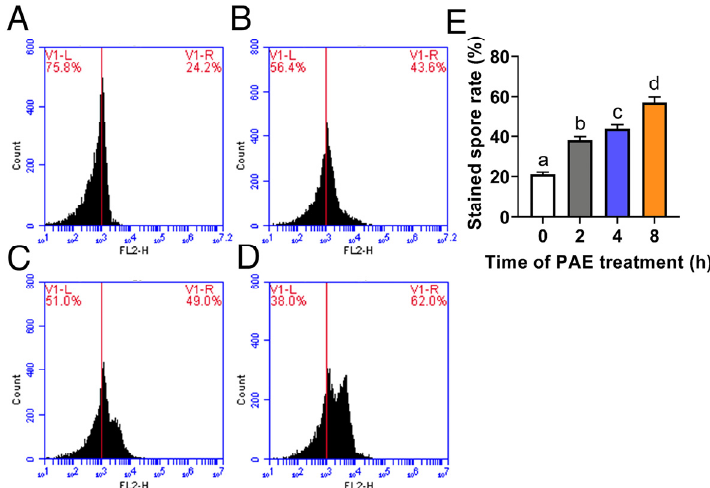
Figure 4. Distribution of fluorescence intensity values of cell membrane integrity in F. solani detected by PI staining, after spores exposed to 1.5 mL/L PAE for 0 ( A ), 2 ( B ), 4 ( C ) and 8 ( D ) h. Bar graph of rate of stained spores ( E ). Values are mean ± standard deviations ( n = 3). Different letters indicate statistically significant differences ( p < 0.05) calculated by one-way ANOVA.